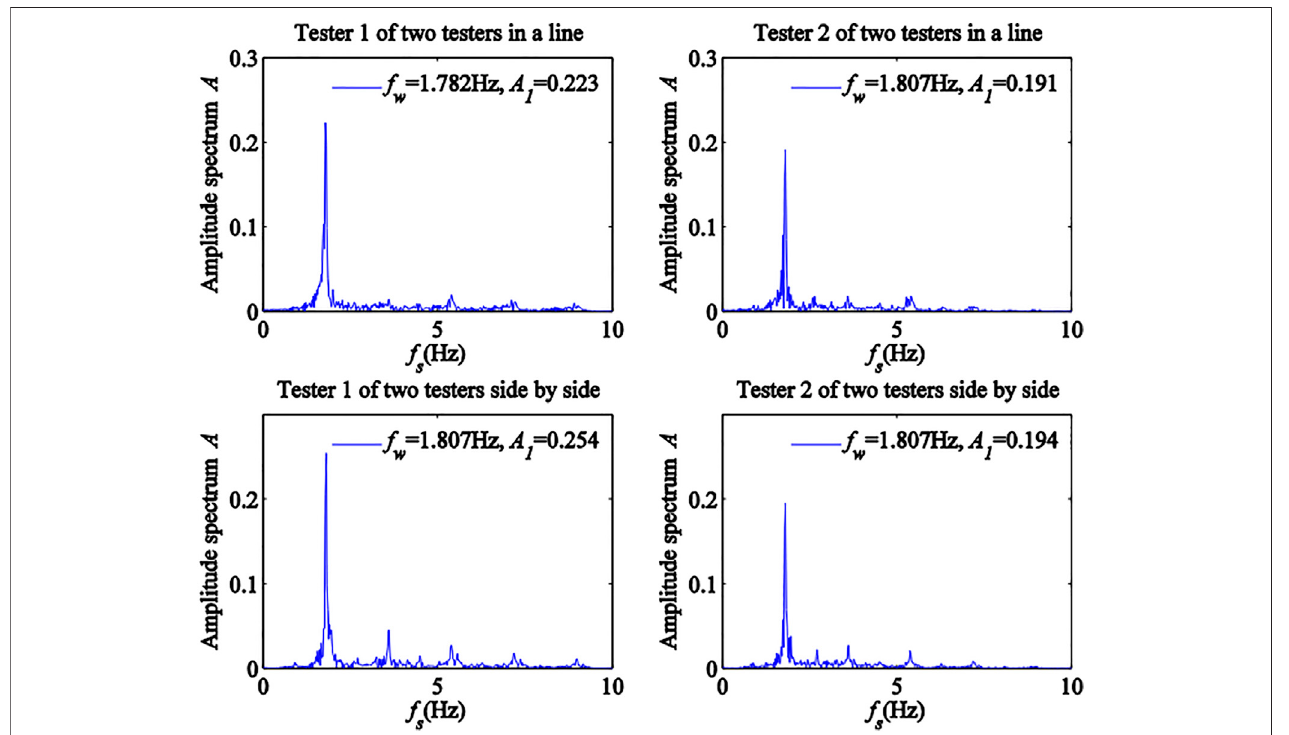
FIGURE 11 | Power spectra of pedestrian walking loads for two testers in a line or side by